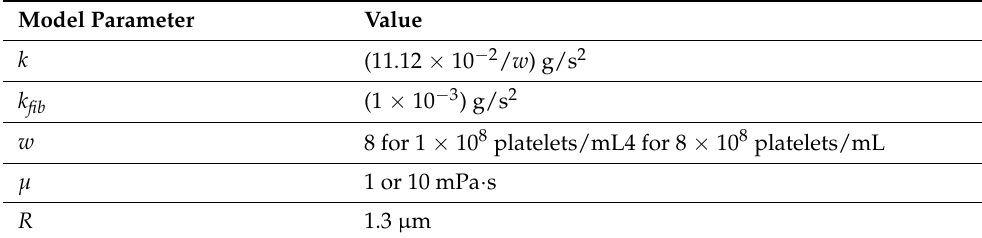
Table A1. Model parameters used in